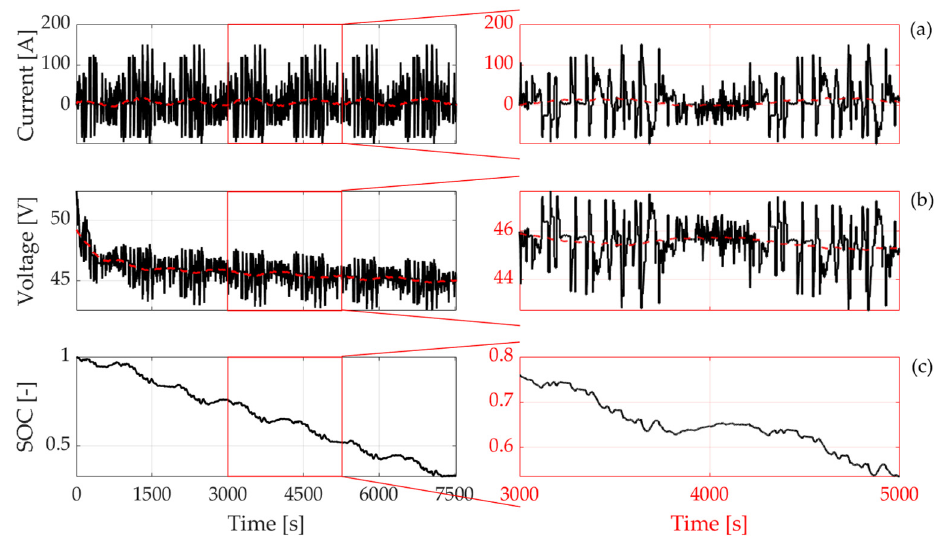
Figure 8. Training dataset for NARX RNN—layout 2: ( a ) current (solid black) and averaged current (dashed red), ( b ) voltage (solid black) and averaged voltage (dashed red) , ( c ) SOC.